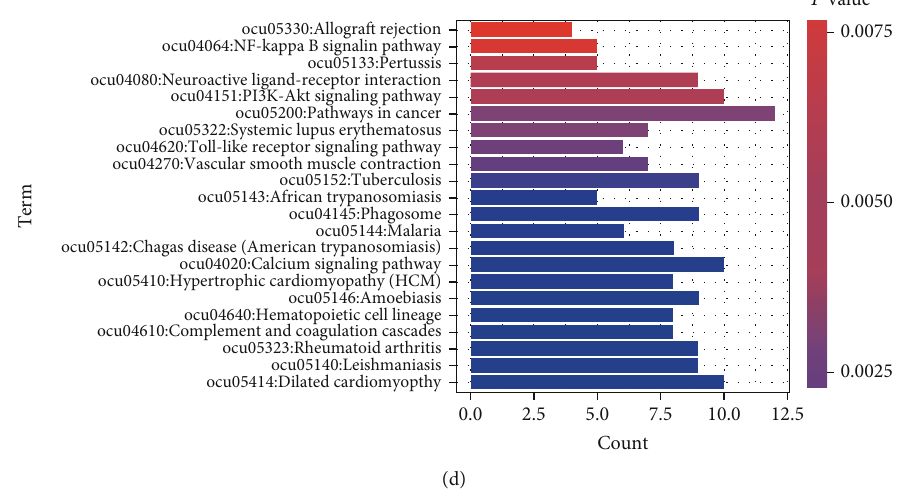
Figure 2: Screening results of di ff erentially expressed genes in a rabbit pancreas tissue microarray. (a) Heat map of di ff erentially expressed gene construction. (b) Volcano map of di ff erentially expressed gene construction. (c) GO enrichment results of di ff erential genes. (d) KEGG pathway enrichment results of di ff erential